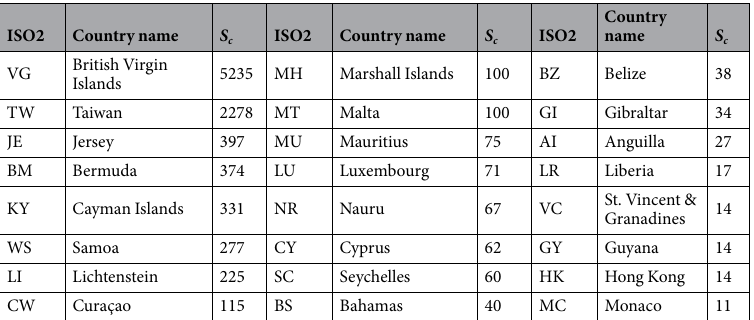
Table 1. List of sink-OFCs, ordered by sink centrality value.